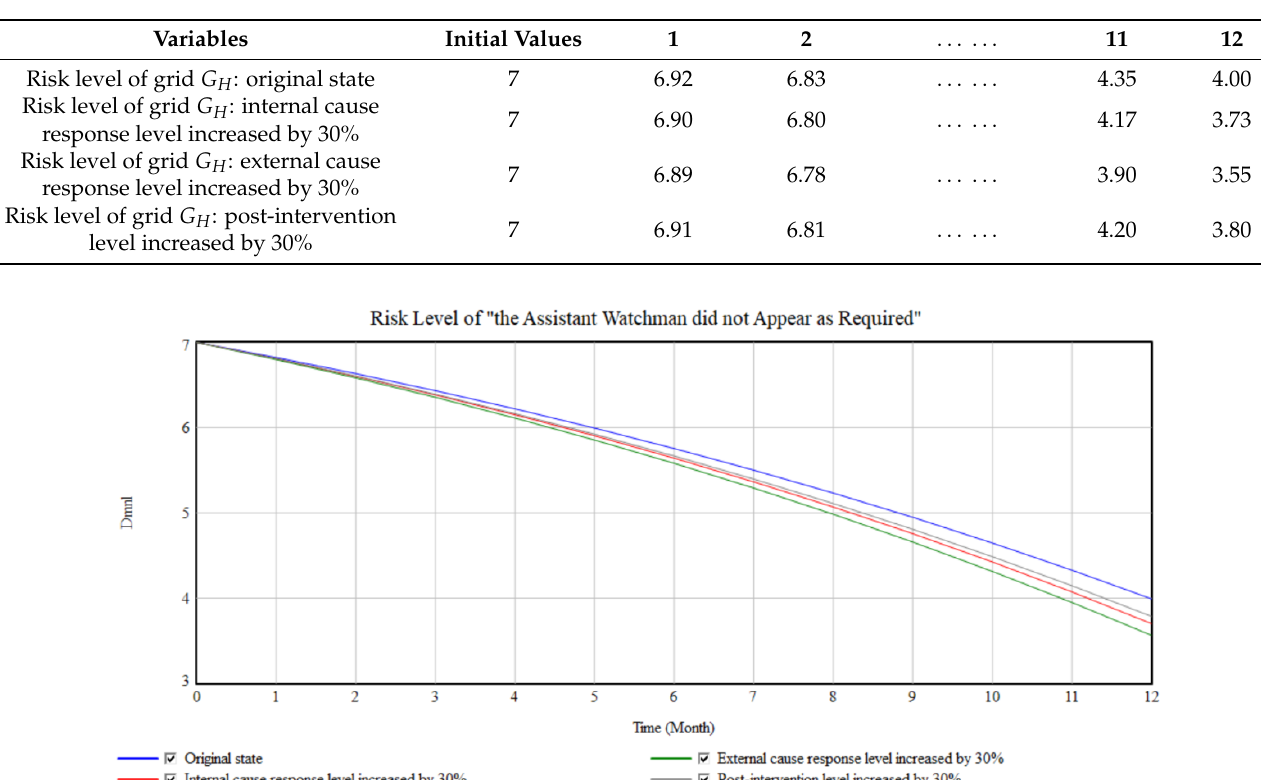
Table 8. Comparative analysis of intervention effects in different scenarios.